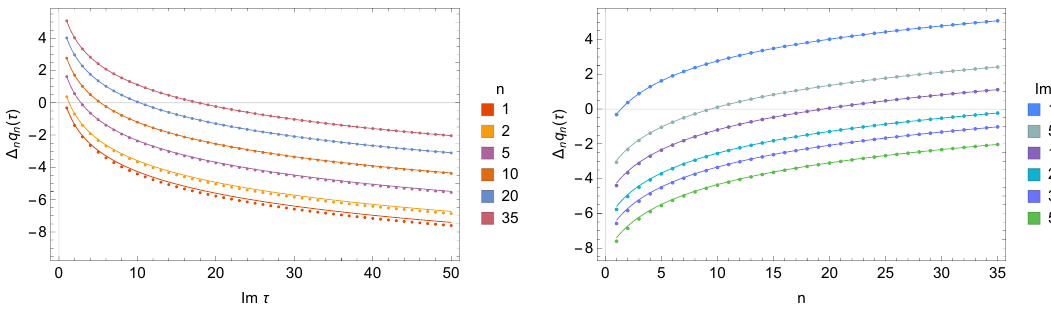
Figure 1 . First variation ∆ n q n ( τ ) as function of Im( τ ) for fixed values of n (left) and as function of n for fixed values of Im( τ ) (right). The dots are numerical values estimated from localization, the continuous lines are the lqne prediction in eq.